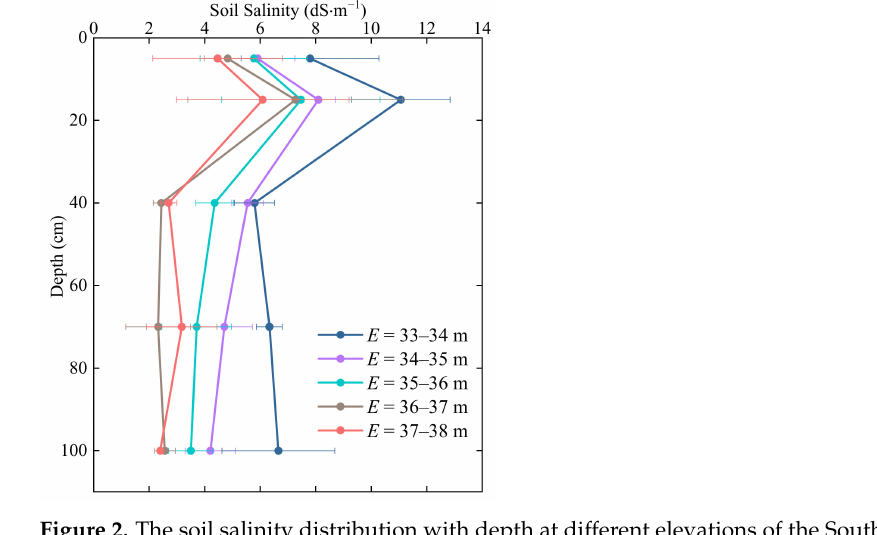
Figure 2. The soil salinity distribution with depth at different elevations of the South Aral Sea ( E is the elevation).